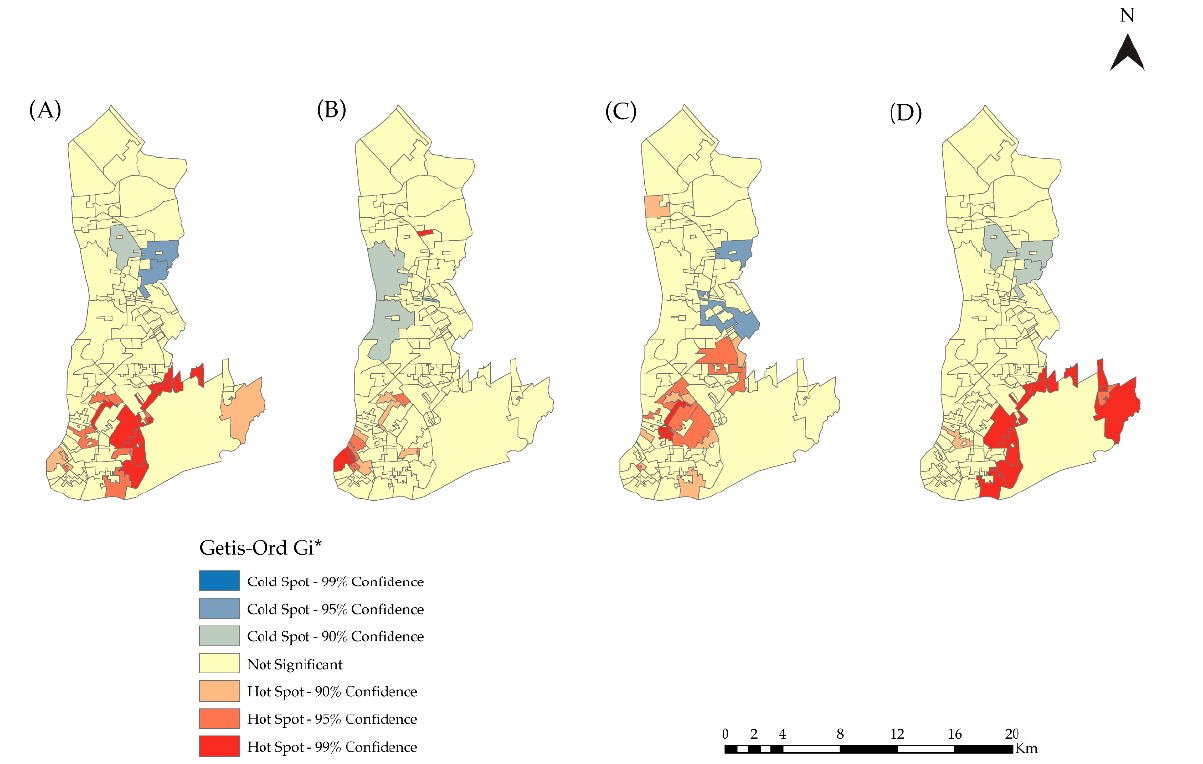
Figure 4. Map of Gi* local results. ( A ) 2007–2018, ( B ) 2007–2010, ( C ) 2011–2014, and ( D ) 2015–2018 in Belém, PA, Brazil.